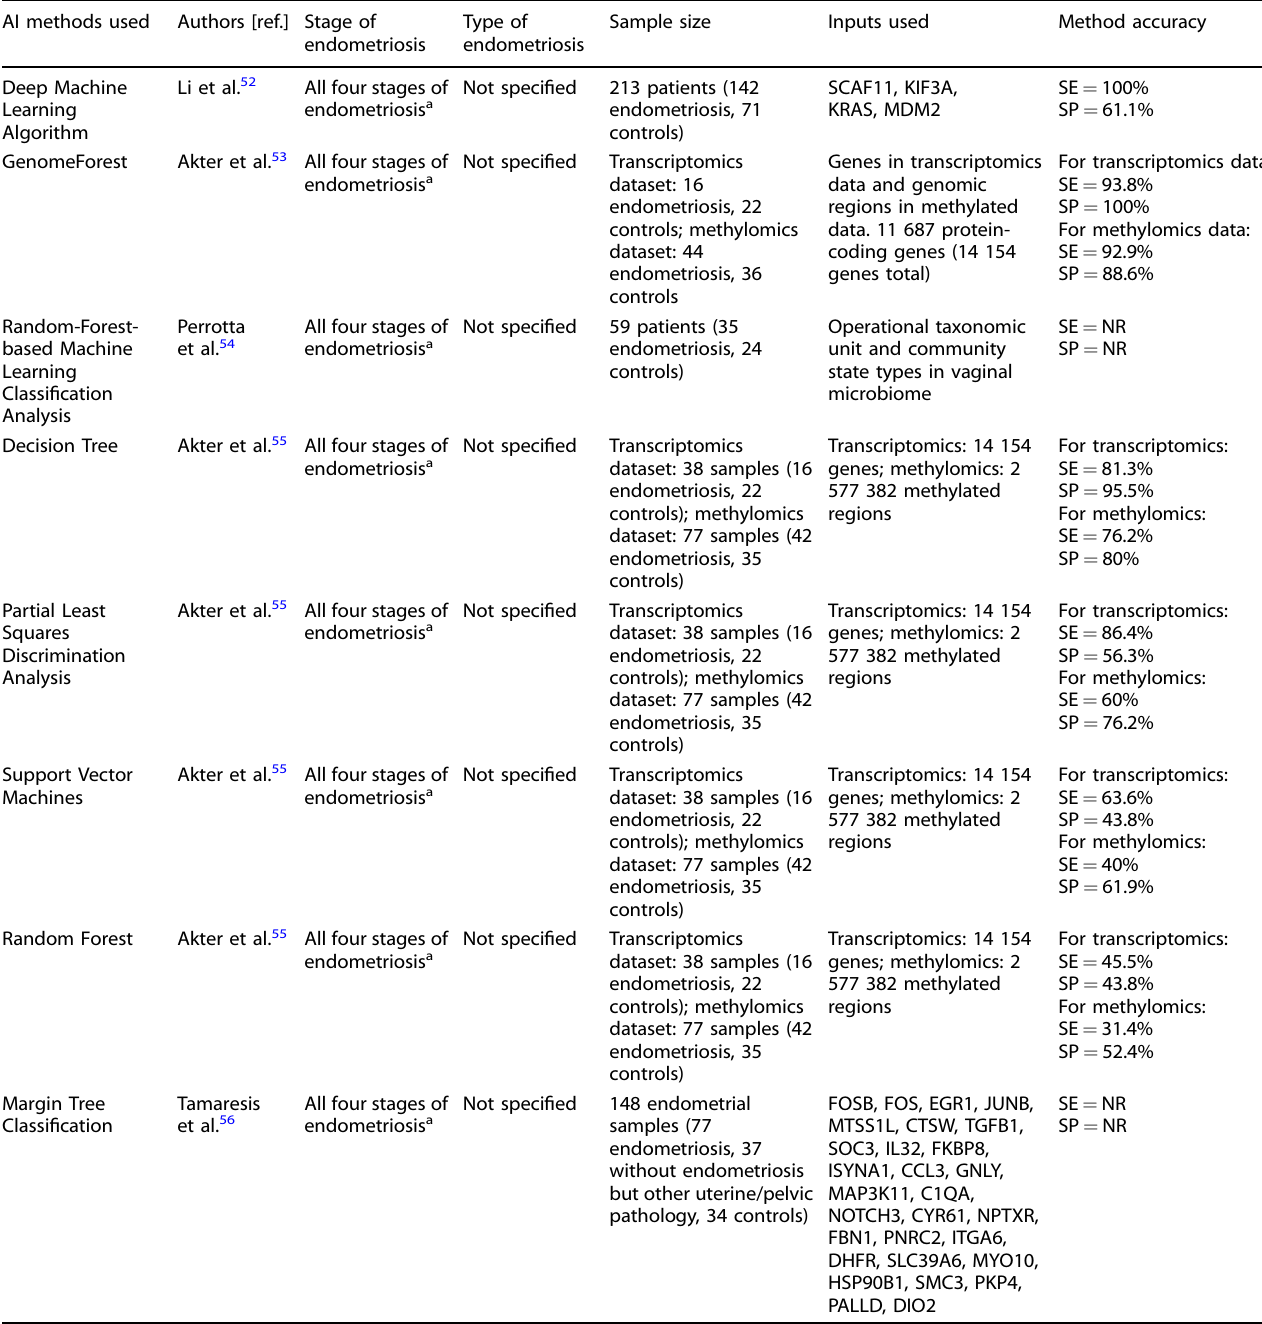
Table 5. Diagnostic and predictive models built using genetic